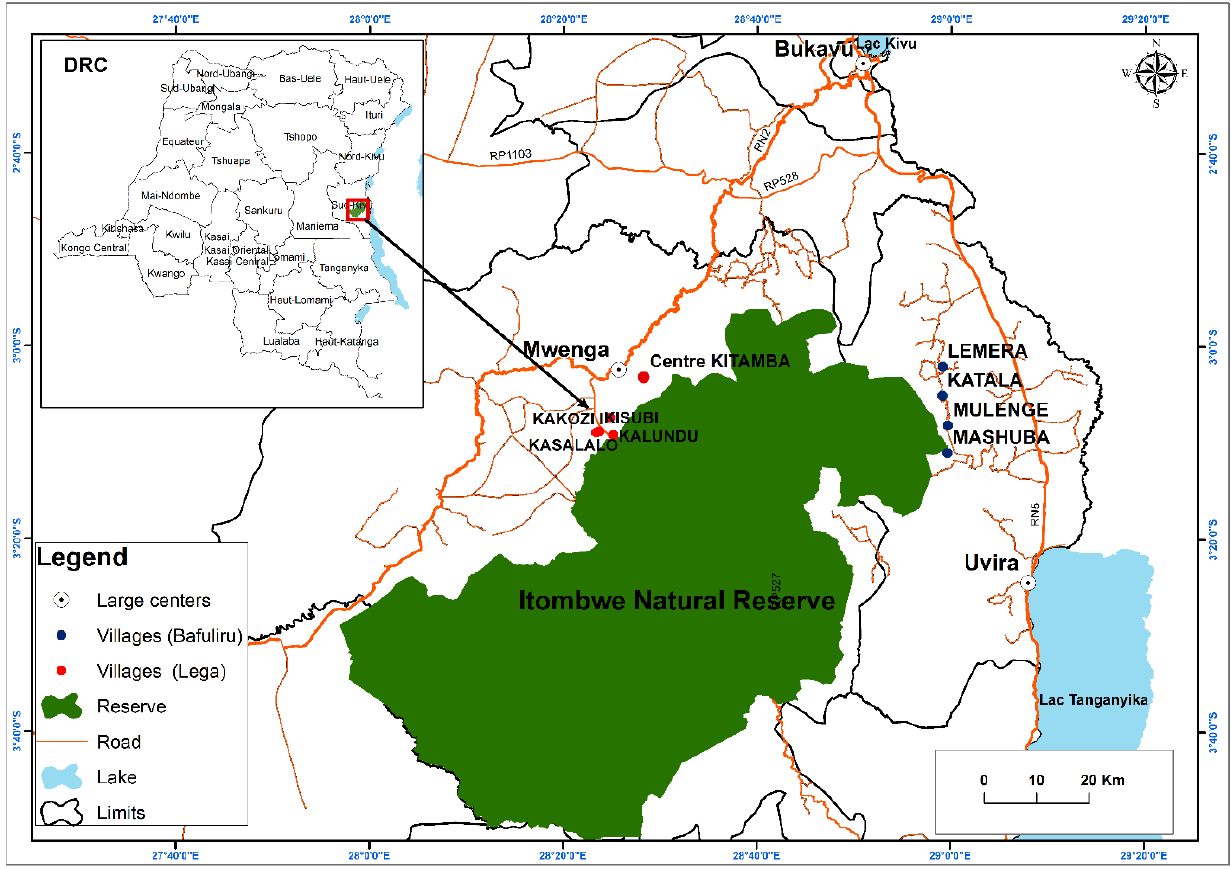
Figure 1. Study area with the location of the Lega and Bafuliru villages sampled.